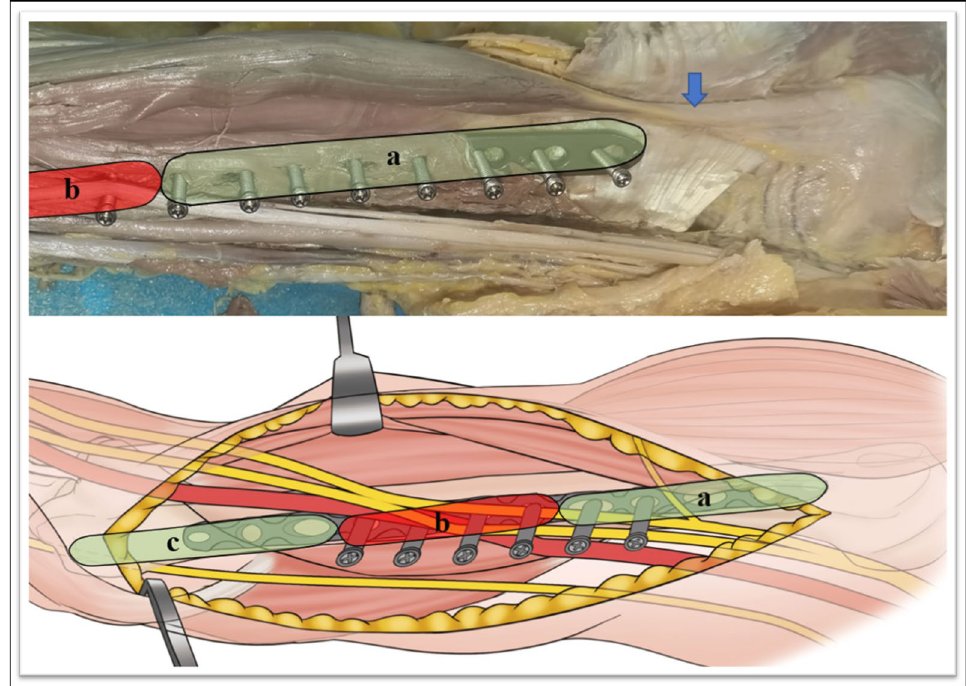
Fig. 5 This figure shows the distance, parallel to the long axis of the humerus, from the medial base of the humeral head to the intersection of the median nerve and the proximal end of the underlying steel plate ( a ). The green areas indicate the safe area for screw placement ( a and c ). The blue arrow indicates the long head of the brachii tendon. Percutaneous screw fixation is not suitable between the distal and proximal incisions ( b ; the red areas )